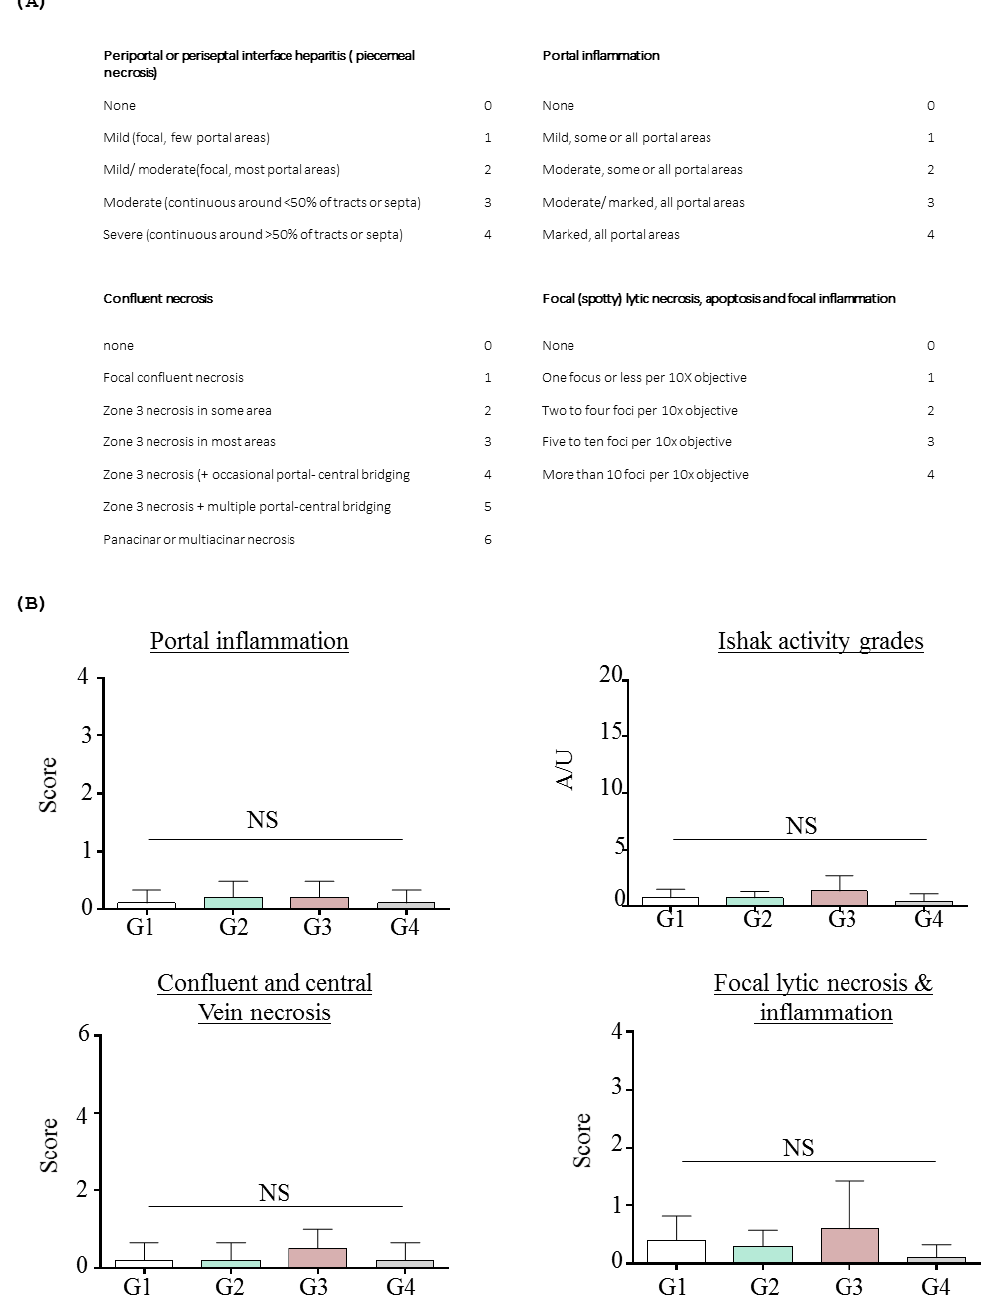
Figure 3. Histological grading of hepatitis inflammation in the repeated dose toxicity study. In the experiment, mice were treated with INO95 and INO20 for 13 weeks. On day 91, livers were collected and analyzed. ( A ) Histology ishak score. ( B ) The grading of histology ishak score between groups. The data shown represent mean ± S.D. ( n = 5). Abbreviation: NS: Not significant.